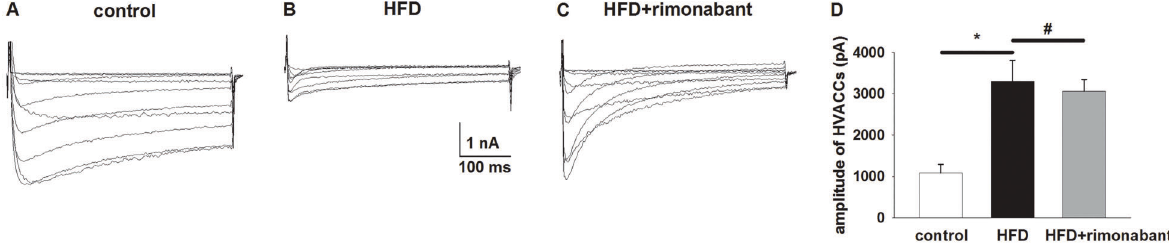
Figure 3. Changes in the amplitude of high voltage-activated calcium channels (HVACCs) in soleus muscle cells from regular diet (control, A ), HFD diet ( B ) and HFD + rimonabant ( C ) groups. D , Summary data of HVACCs amplitude in the three groups. Data are reported as means ± SE. *P o 0.05, regular vs HFD; # P o 0.05, HFD vs HFD + rimonabant (one-way ANOVA followed by Duncan ’ s post hoc test